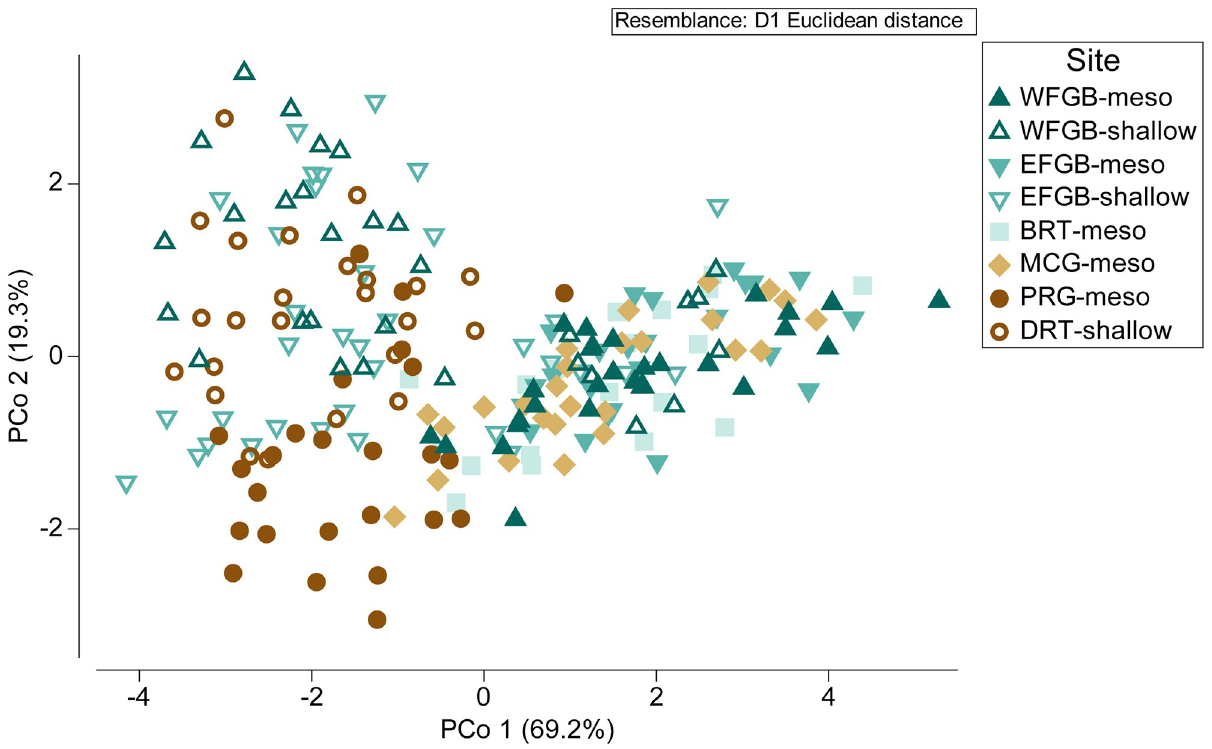
Fig 3. Principal coordinates analysis. Principal coordinates analysis (PCoA) ordination of corallite morphology across six sites in the Gulf of Mexico, explaining 88.5% of the total variation (PCo 1: 69.2%, PCo 2: 19.3%). Degree of difference among samples represented by Euclidean distance between sample points. Color and shape of each point corresponds to site and depth